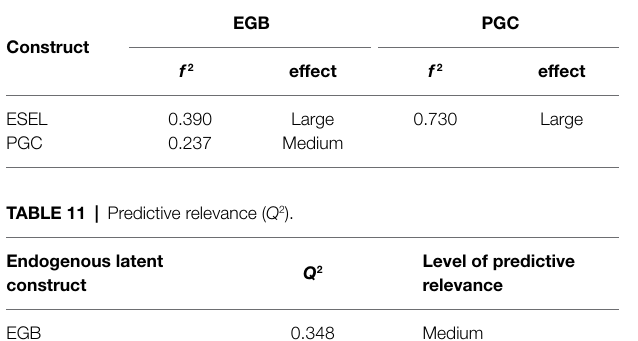
TABLE 10 | f 2 —effect size to R 2 .